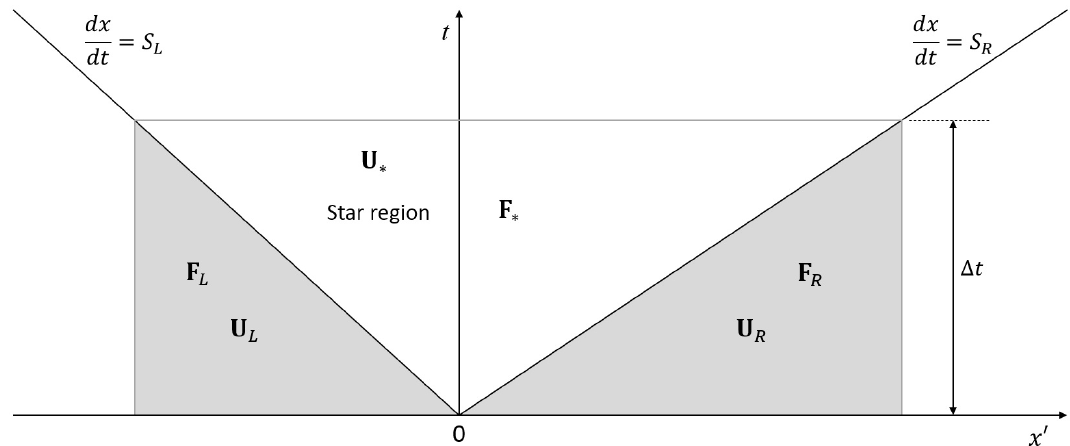
Figure 3. HLL Riemann solver of